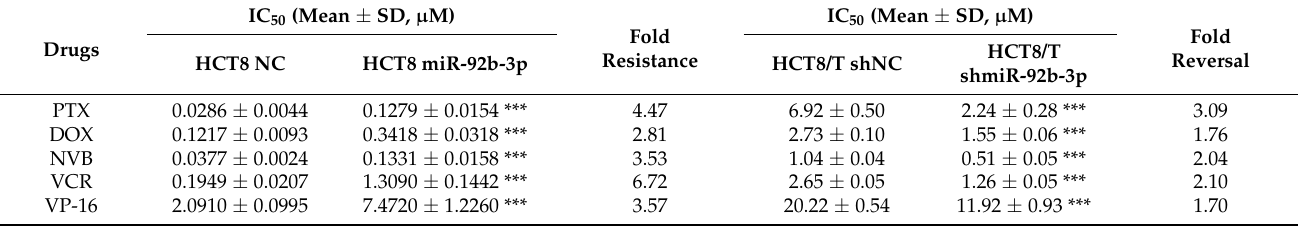
Table 1. The effect of miR-92b-3p on sensitivity of HCT8 and HCT8/T cells to chemotherapeutic drugs. IC 50 (Mean ± SD, µ M) Drugs